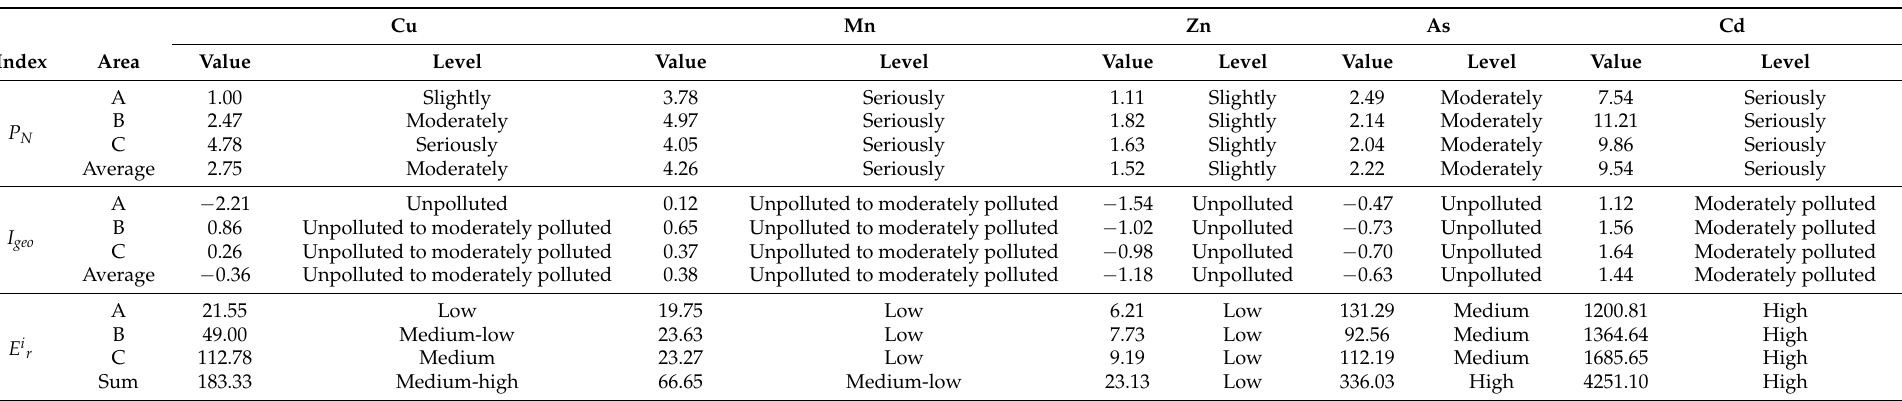
Table 3. Soil pollution levels of heavy